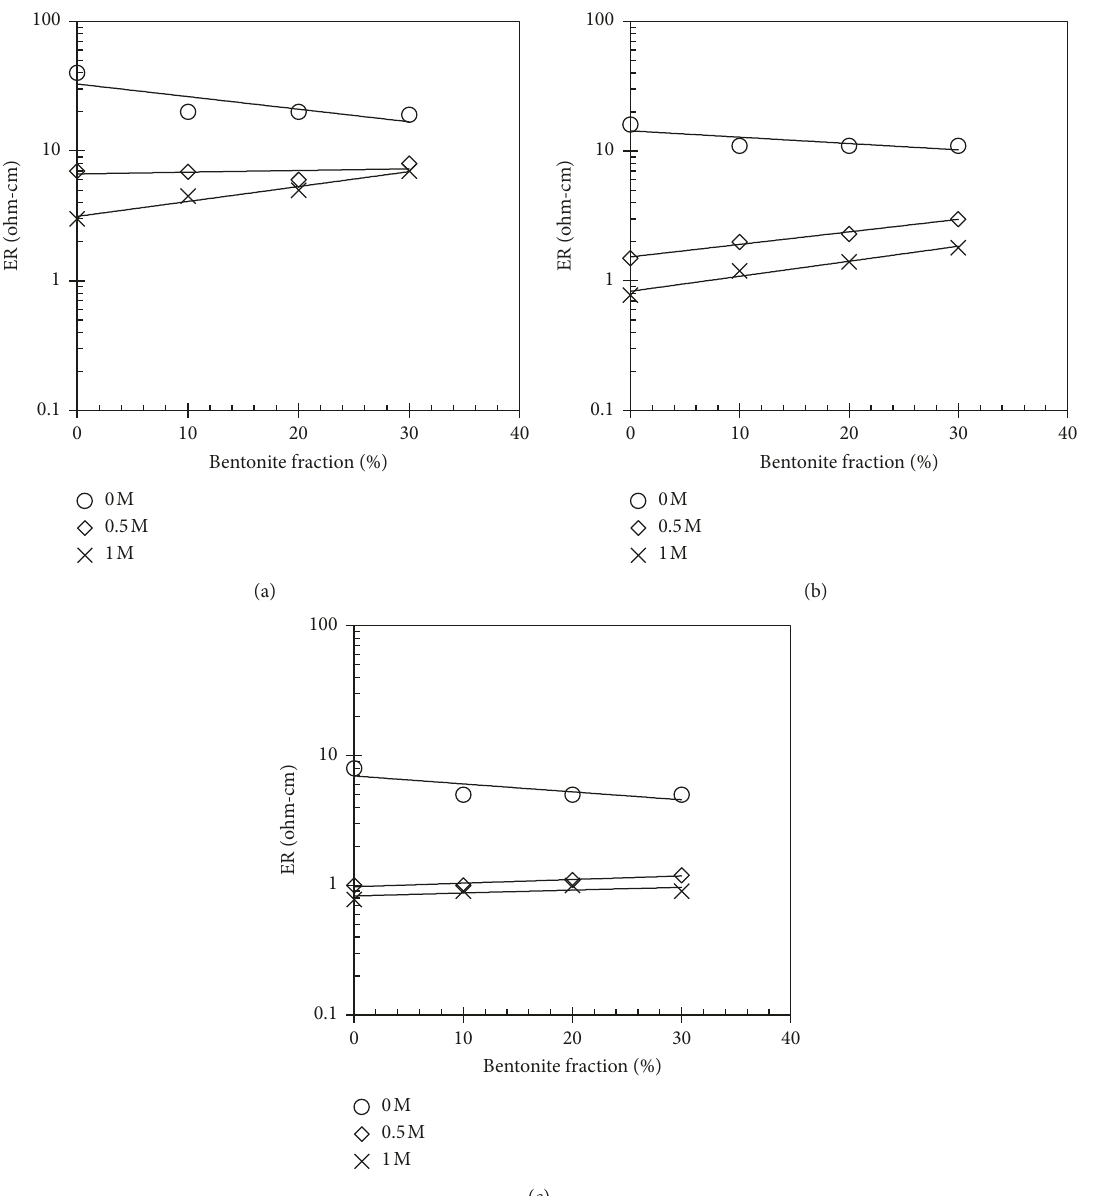
3 ), (b) W c (cid:31) 20%, ρ d (cid:31) 1.4 (g/